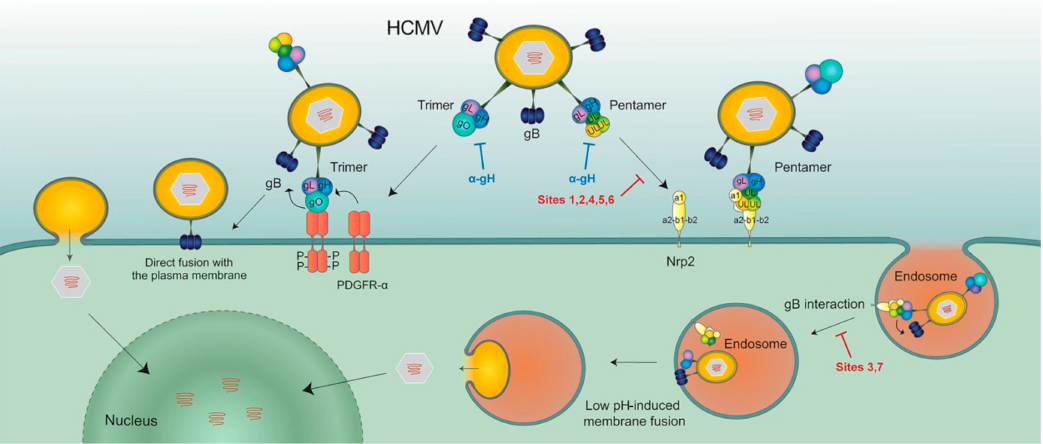
Figure 5. Models of HCMV entry into human cells using the trimer complex (TC) or PC